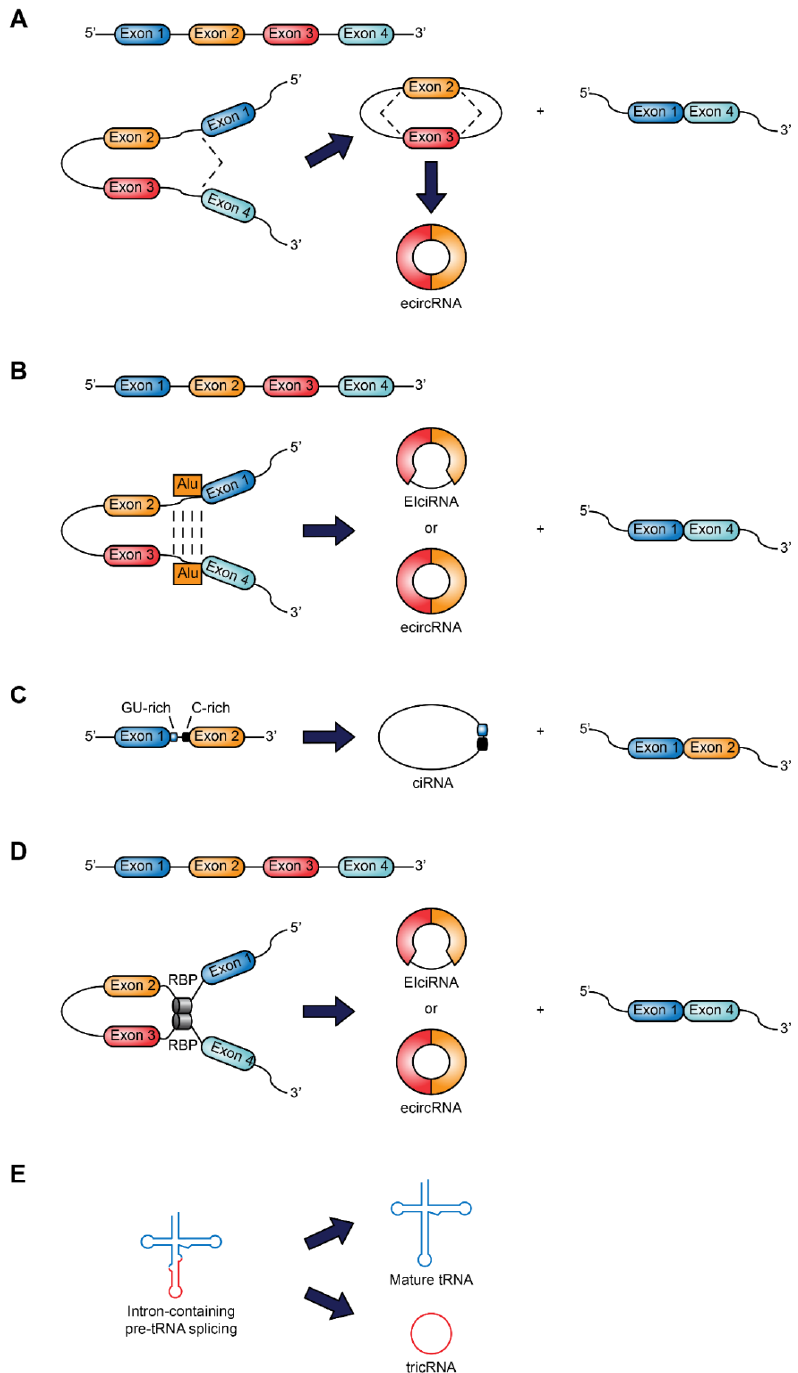
Figure 1. Classification and biogenesis of circRNAs. ( A ) Lariat-guided circularization: an exon skipping event leads to a lariat structure that contains exons 2 and 3, formed by the link between the 3 (cid:48) end of a donor exon with the 5 (cid:48) end of the acceptor exon, and a linear product consisting of exons 1 and 4. EcircRNA is formed after removal of introns. ( B ) Circularization is driven by